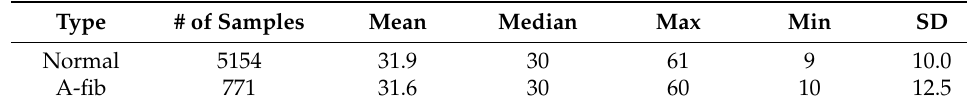
Table 1. Data Profile from PhysioNet Challenge 2017: Statistics of the sample lengths (in seconds) for each type.